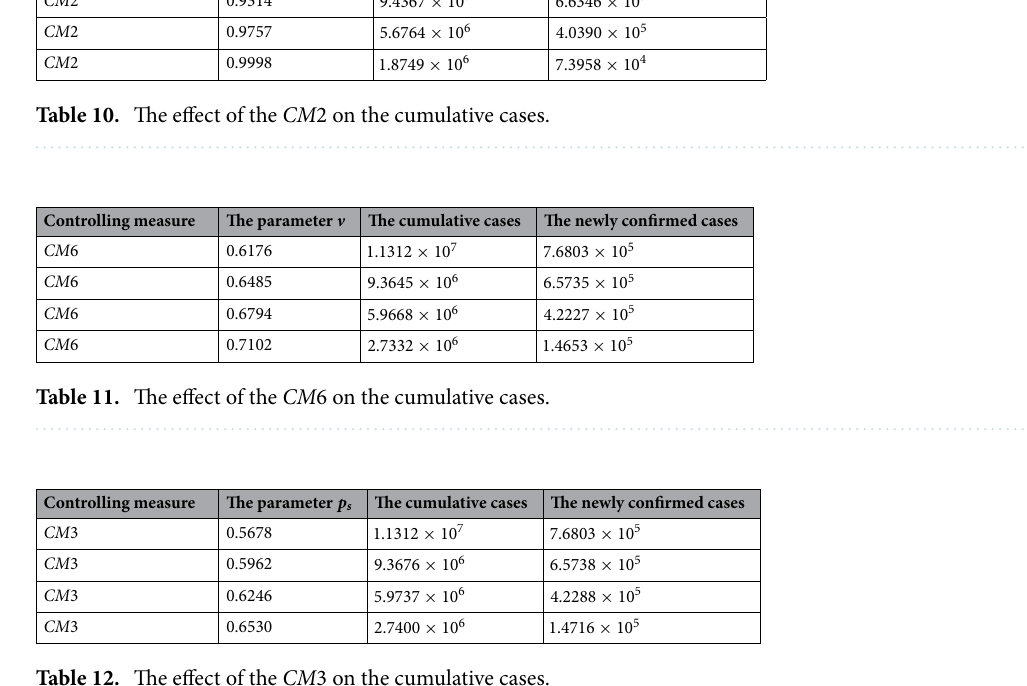
Table 12. The effect of the CM 3 on the cumulative cases.